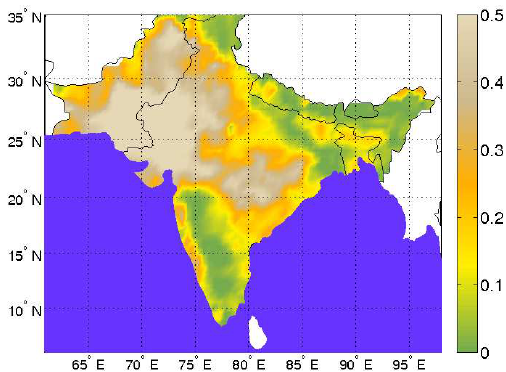
Fig. 1: Topographic map of the region concerned in the data set and the analysis. The colour represents the height above sea level in meters. This map is obtained from ETOPO1, the 1 arc minute gridded global relief data provided by NOAA Fig. 2: Partitions of mean seasonal rainfall based on the data analysed from 1961 to 2004 (data used APHRO–V0902).